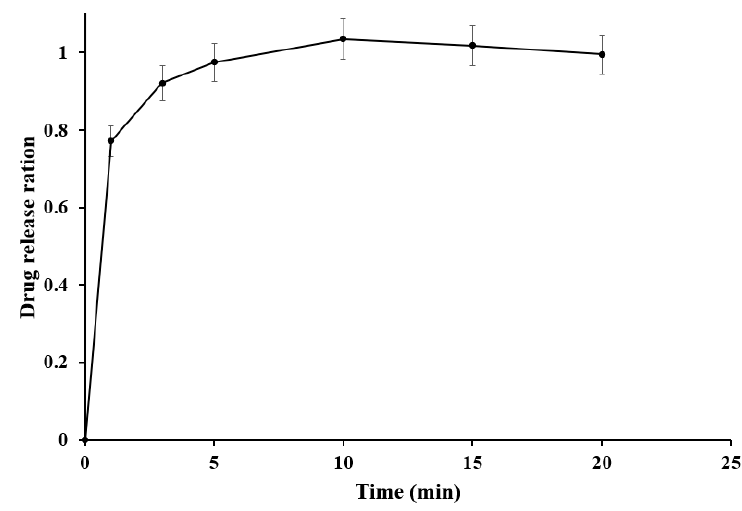
Figure 6. Drug dissolution profile for orodispersible film prepared from tamarind seed gum substrate. Table 3. Actual drug content in the prepared orodispersible films and percent of drug content